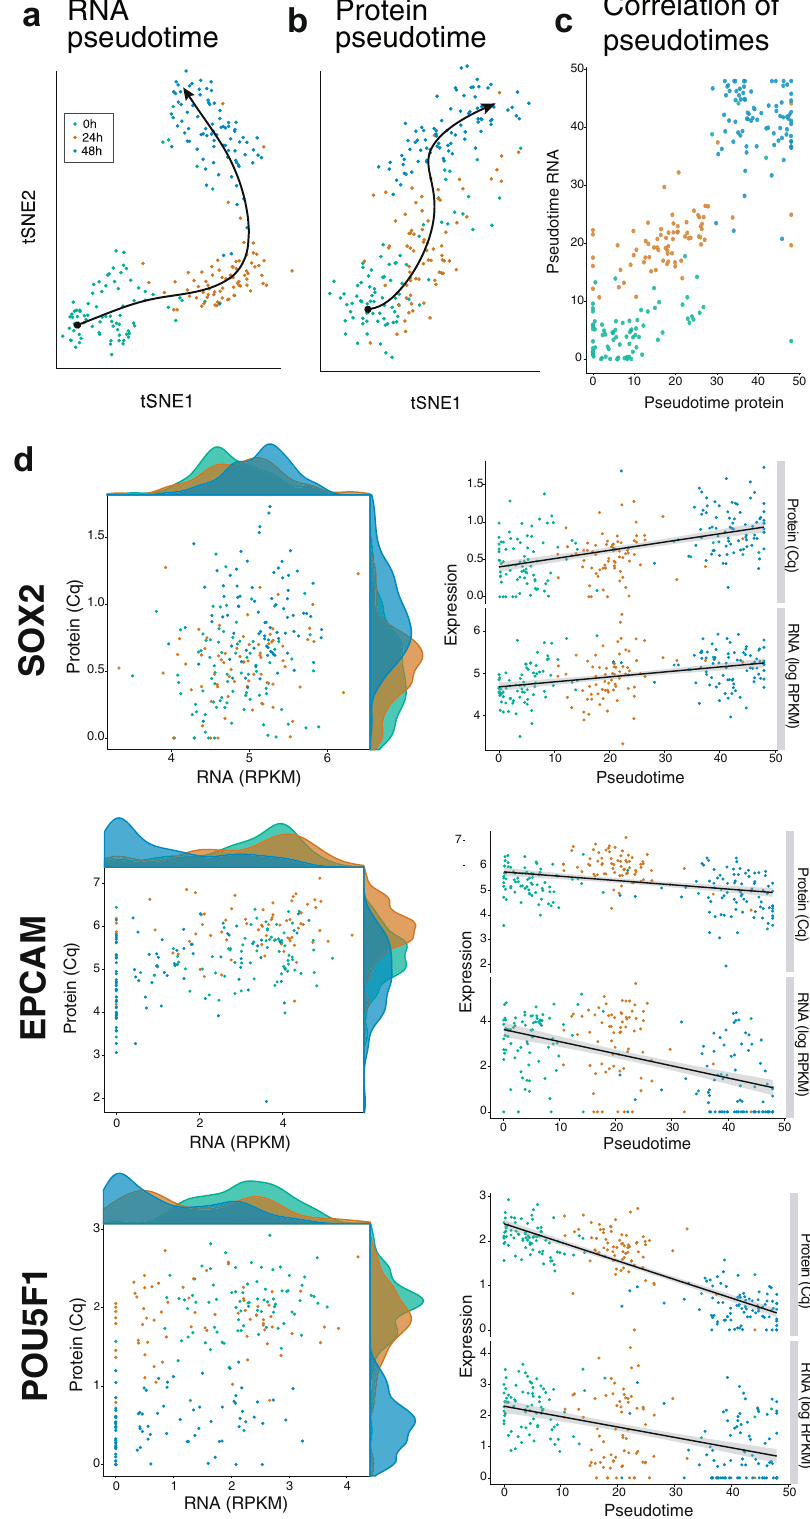
Fig. 2 mRNA abundance only partially re fl ects and protein abundance in single cells. tSNE plot and pseudotime analysis of the a normalized mRNA and b protein expression data. c Comparison of the cell pseudotime-ordering if calculated based on either mRNA or protein expression data. d Example mRNA and protein expression data plotted for SOX2, EPCAM, and POU5F1. The data is shown either as RNA expression vs. protein expression scatter plot with respective density plots included on each axis, or as cells ordered along RNA pseudotime with either RNA and protein expression plotted on the y -axis. Both the RNA and protein data are plotted as log2. Color corresponds to time point in all plots 0 h (green), 24 h (orange), and 48 h